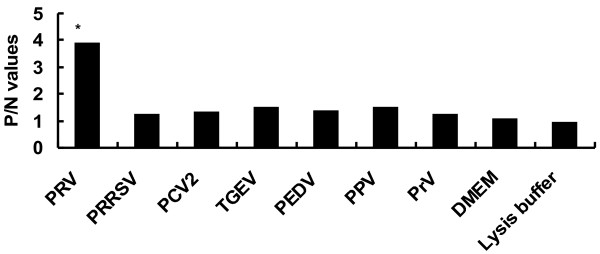
Discrimination ELISA. PRV, Porcine transmissible gastroenteritis virus (TGEV), Porcine epidemic diarrhea virus (PEDV), Porcine circovirus type II (PCV2), Porcine reproductive and respiratory syndrome virus (PRRSV), Porcine pseudorabies virus (PrV) and Porcine parvovirus (PPV), DMEM medium and virus lysis buffer were coated onto ELISA plates individually. The wells were incubated with the anti-PRV antibody followed by incubation of HRP-conjugated secondary antibody. The names of the pathogens are indicated in x axis; The OD490 value of tested samples (P)/the OD490 value of negative control, coating buffer (N)>2 is judged as positive. *compared with other group (p<0.01). The P/N values were the mean values from three independent assays.